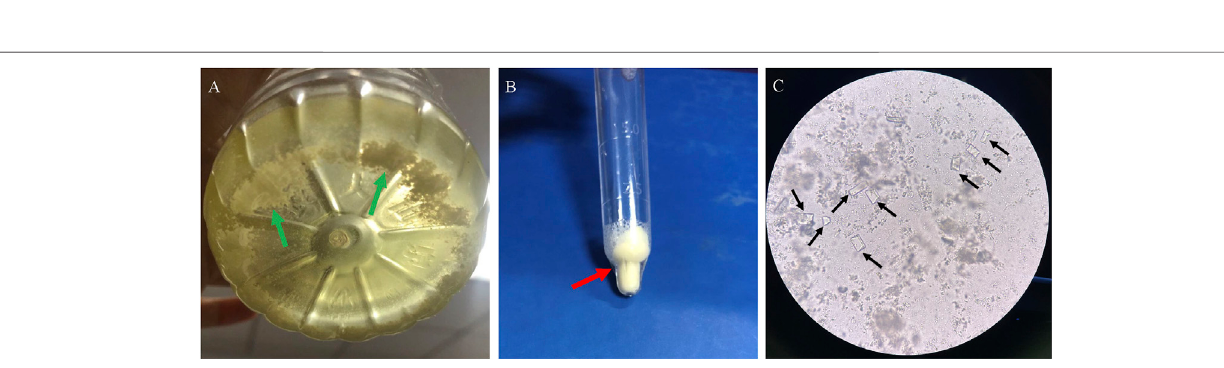
Frontiers in Genetics |